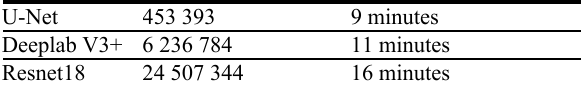
Table 4. Global training